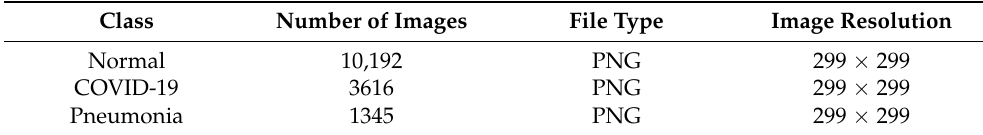
Figure 2. Example CXRs of COVID-19 Radiography Dataset [26,27]. Table 1. COVID-19 RADIOGRAPHY DATABASE (version